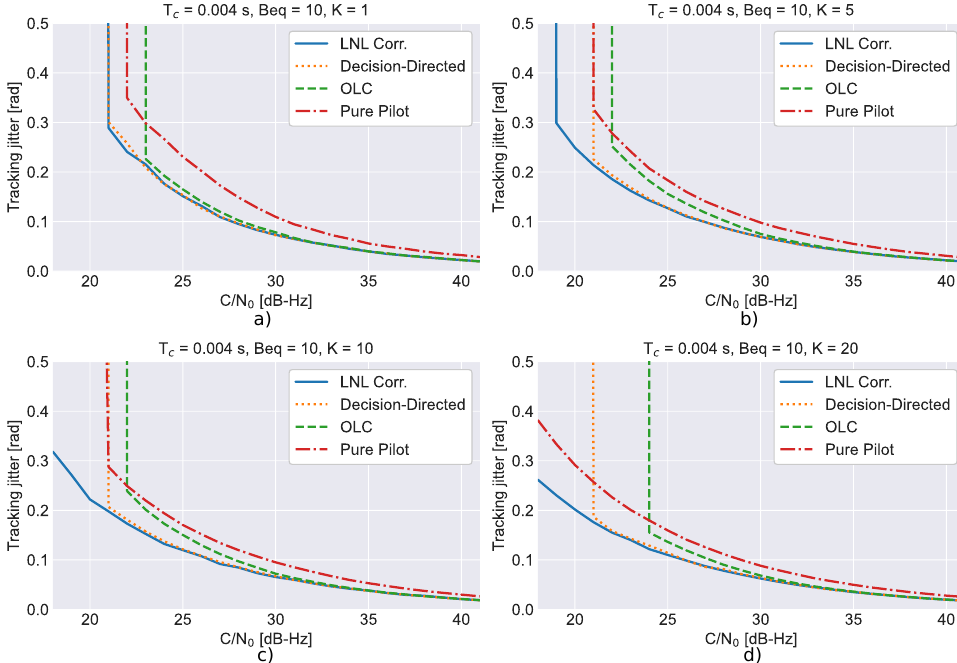
Figure 5. Comparison between the tracking jitters obtained using semi-analytic simulations for differ- ent data/pilot combining strategies with extended integration time. ( a ) K = 1, ( b ) K = 5, ( c ) K = 10, ( d ) K =